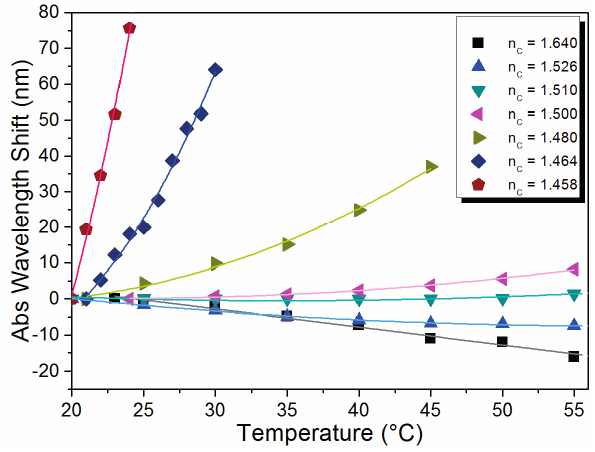
Figure 5. Absolute wavelength shift measured experimentally as a function of temperature for different liquid core refractive